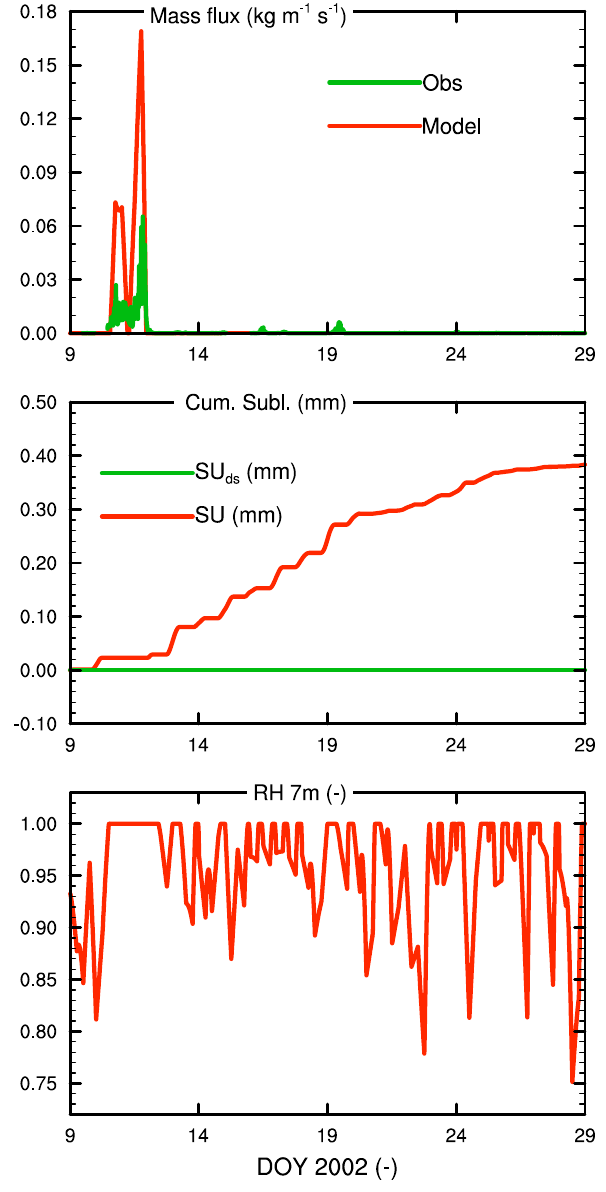
Fig. 8. Time evolution of the snow drift fluxes at Kohnen during the first part of the EPICA-ENABLE campaign, from 9 January until 29 January 2002. The upper panel shows TR ds , the panel below gives cumulative SU ds , together with surface sublimation (SU). The green line in the upper panel gives the observed mass fluxes, the red line shows the model results. After this period no snowdrift events were observed or modelled.